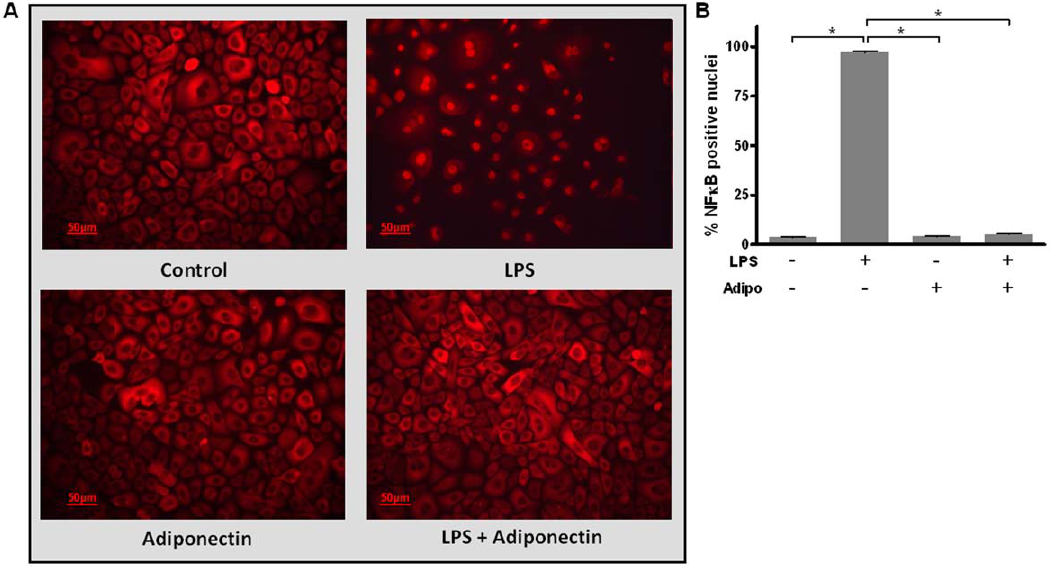
Figure 3. Effect of lipopolysaccharide and/or adiponectin on NF k B signaling. Effect of lipopolysaccharide (LPS; 2 m g/ml) and/or adiponectin (Adipo; 1 m g/ml) on the nuclear translocation of NF k B at 2 h. NF k B visualized by immunofluorescence (A). Quantitative analysis of immunofluorescence samples; evaluation as % NF k B positive nuclei (B).